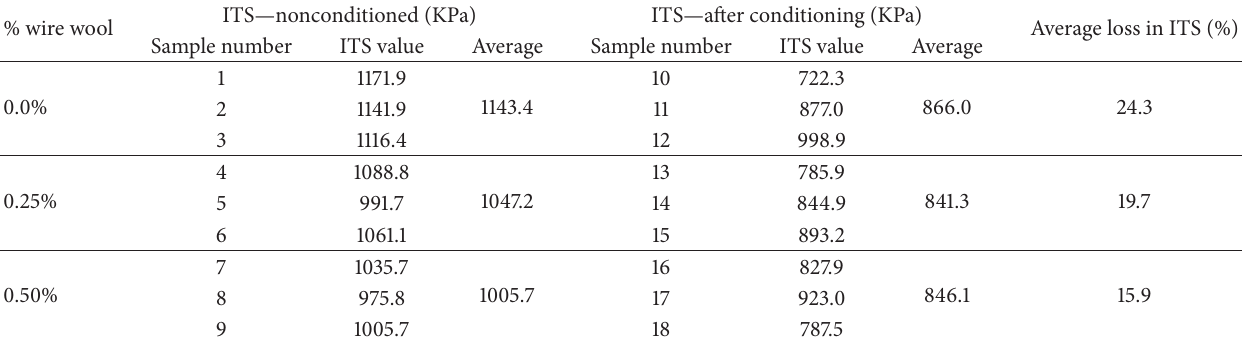
Table 4: Effect of wire wool addition on the indirect tensile strength (ITS).